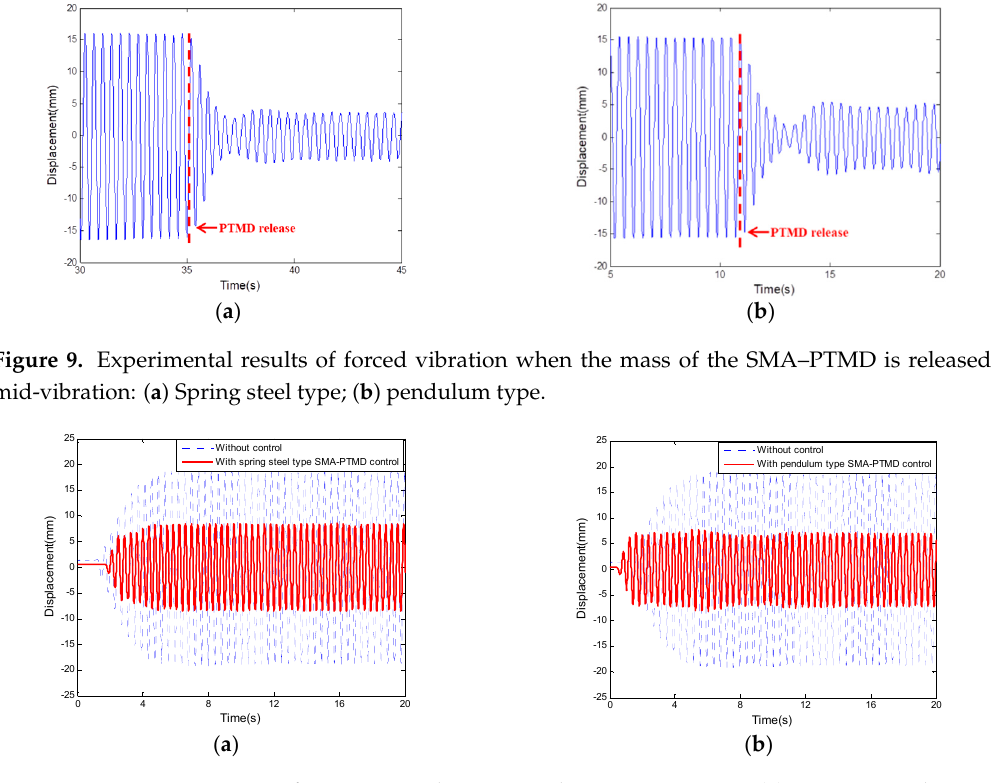
Figure 10. Comparison of resonant vibration with SMA–PTMDs: ( a ) Spring steel type; ( b ) pendulum type.